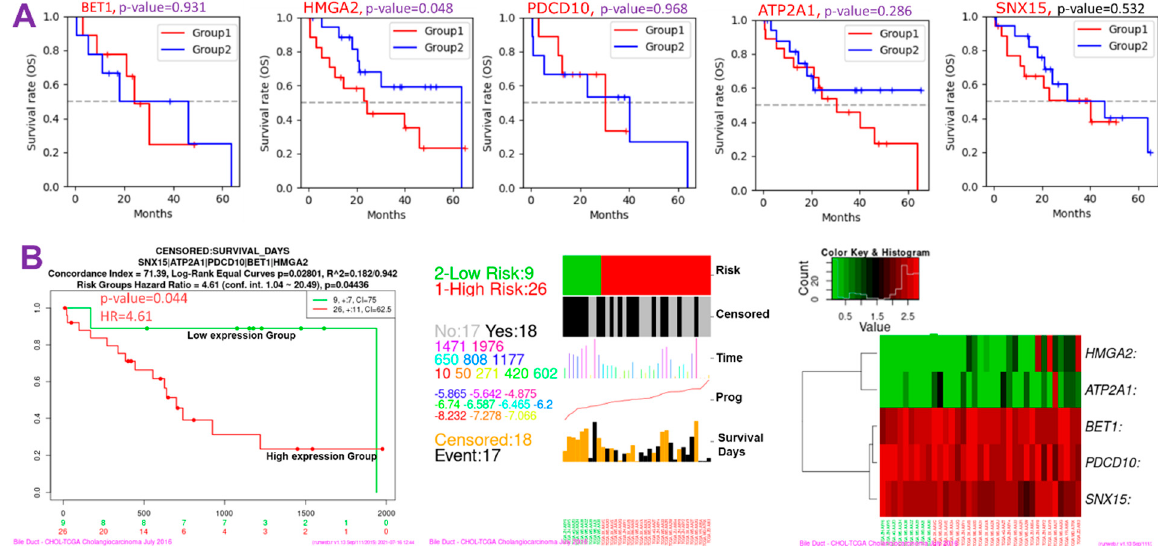
Figure 3. Cholangiocarcinoma (CHOL)-hub genes are associated with higher risks and poorer prognoses of CHOL. ( A ) Kaplan–Meier survival plot ( B ) Kaplan–Meier plots and hazard plots of CHOL-hub genes in CHOL patients.